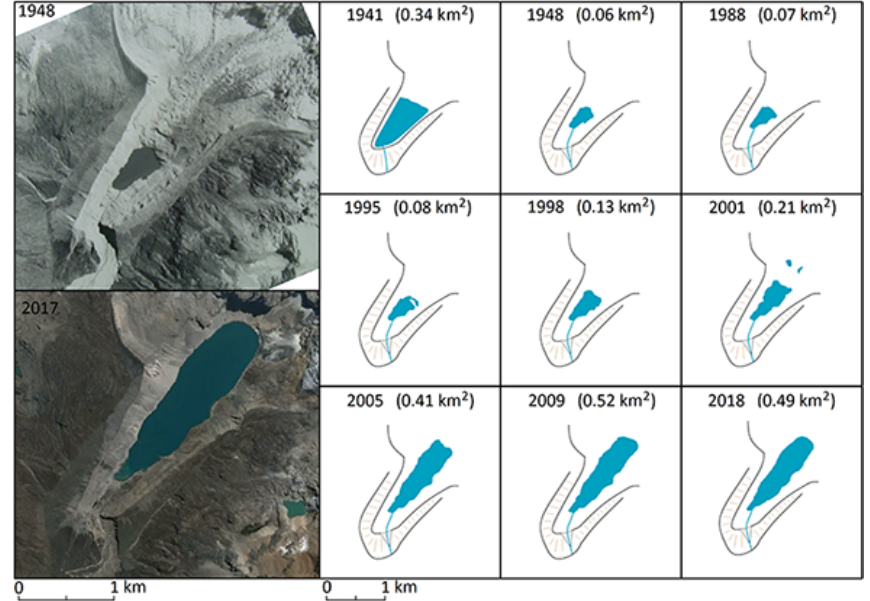
Figure 2. Evolution of lake Palcacocha from 1941 to present (source of 1948 image: Archives of the Autoridad Nacional de Agua, Peru; source of 2017 image: CNES/Airbus image, © Google Earth, date of acquisition: 18 June 2017; source of lake evolution data from 1988– 2018: Landsat images).